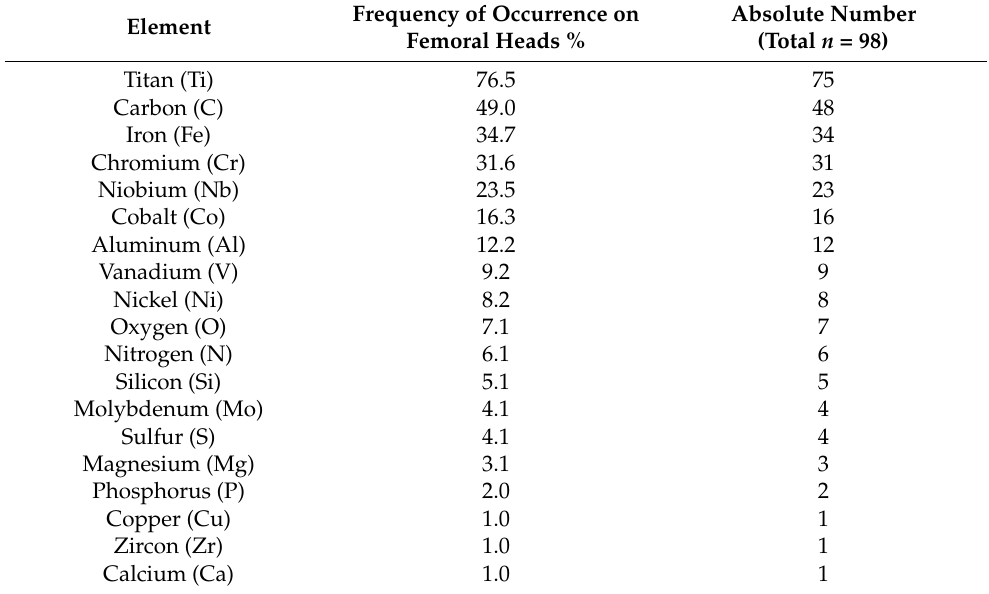
Table 4. Detected deposition materials on femoral heads.